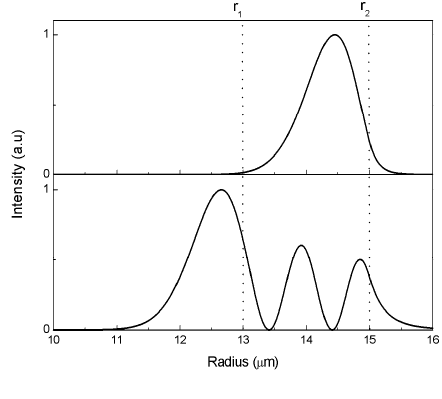
=13 μ m, r =15 μ m, n =1.426, n =1.47, n 1 2 1 2 3